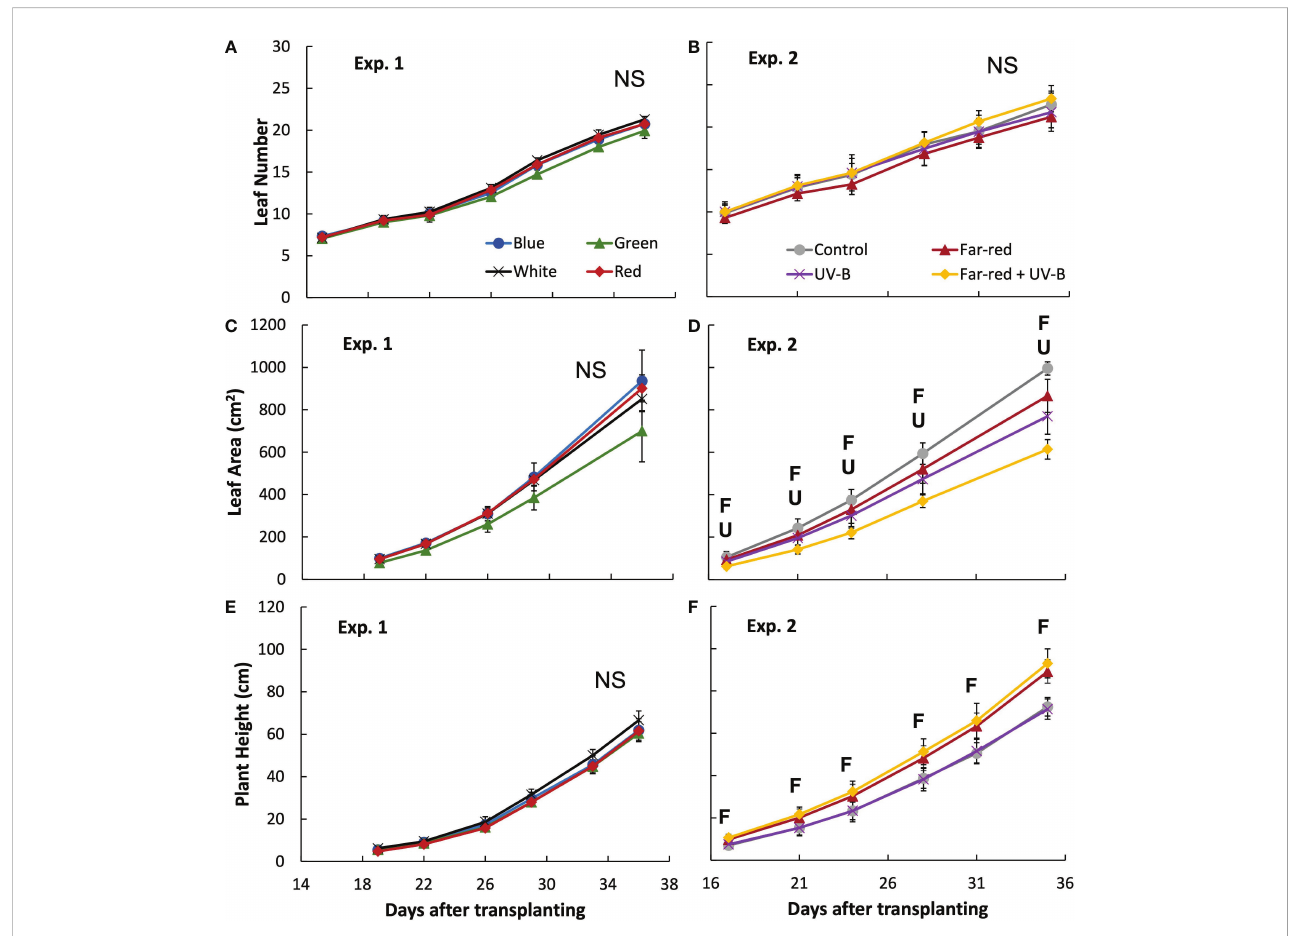
FIGURE 1 Leaf number (A, B) , leaf area on the main stem (C, D) and plant height (E, F) during the experiment in treatments of supplemental radiation within (A, C, E; Exp. 1) and outside (B, D, F; Exp 2) the range of photosynthetically active radiation (PAR) (values are mean ± s.e.; n = 4, with fi ve plants in each statistical replicate). The supplemental radiation of different colours in panels A, C and E had an intensity of 23 mmol m -2 s -1 . The control in panels B, D and F is treatment without supplemental radiation; supplemental far-red radiation resulted in a red to far-red ratio of 0.3 at the plant level,